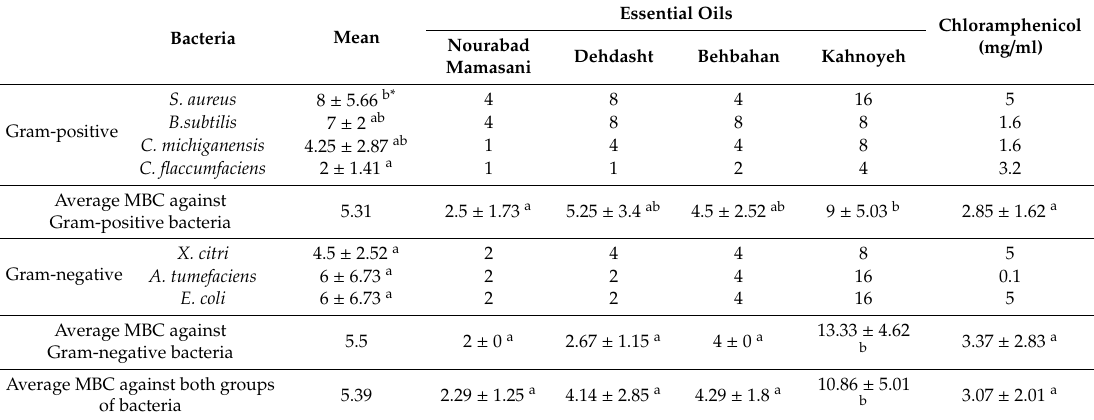
Table 2. Antibacterial activity (expressed as minimum bactericidal concentration, MBC (mg / ml)) of di ff erent essential oils from Oliveria decumbens populations against Gram-positive and Gram-negative